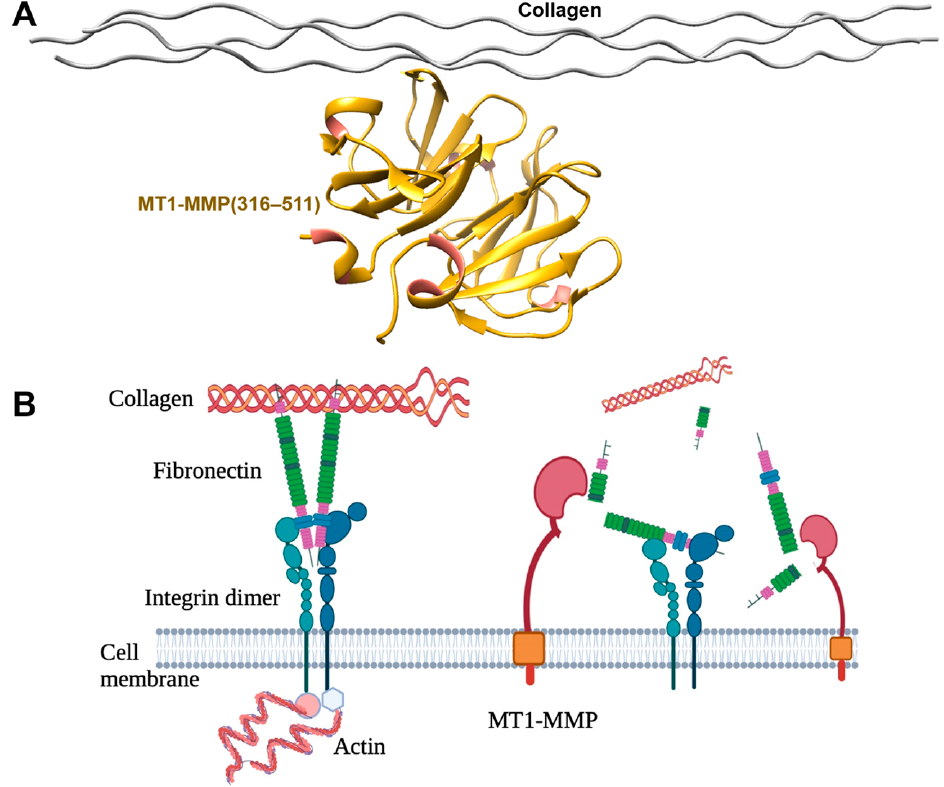
Figure 2. Collagen and fibronectin. ( A ) Solution nuclear magnetic resonance (NMR) structure (PDB code: 2MQS) of hemopexin-like domain of MT1-MMP (316–511) complexed with transient collagen triple helix. ( B ) Fibronectin complex with collagen and integrin during ECM remodeling. MT1-MMP cleaved fibronectin resulted in the disruption of interaction between collagen and integrin on the cell surface.